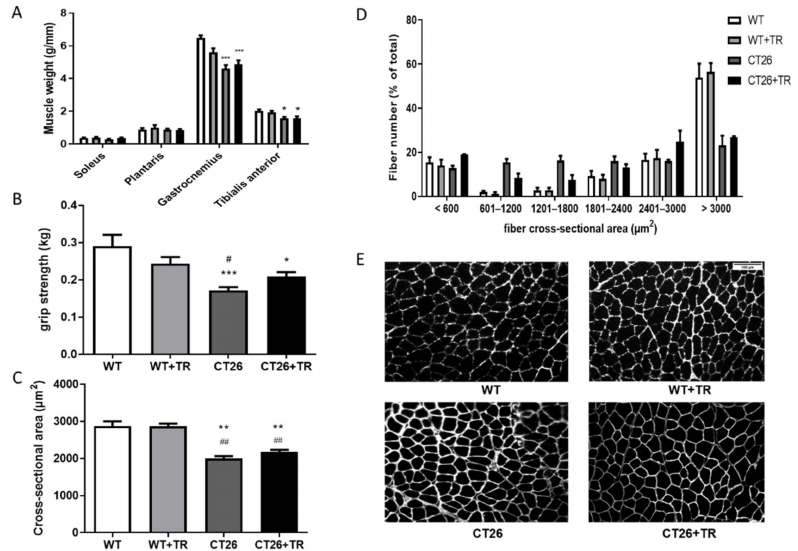
Figure 3. Muscle mass, muscle function and cross-sectional area of CT26 model. ( A ) Soleus, Plantaris, Gastrocnemius and Tibialis anterior muscles mass by tibia length ratio (g/mm); data are reported as means ± SEM, * p < 0.05 vs. WT, *** p < 0.001 vs. WT. ( B ) grip strength (kg); * p < 0.05 vs. WT, *** p < 0.001 vs. WT and # p < 0.05 vs. WT+TR. ( C ) Cross-sectional area ( µ m 2 ); ** p < 0.01 vs. WT and ## p < 0.01 vs. WT+TR. ( D ) percentage distribution of the number of fibers by size. ( E ) Demonstrative Immunohistochemistry image of the cross-sectional area. Groups CT26 cachectic mice: WT—wild type sedentary; WT+TR—wild type trained; CT26—colon cancer sedentary; CT26+TR—colon cancer trained, Scale bar: 100 µ m.